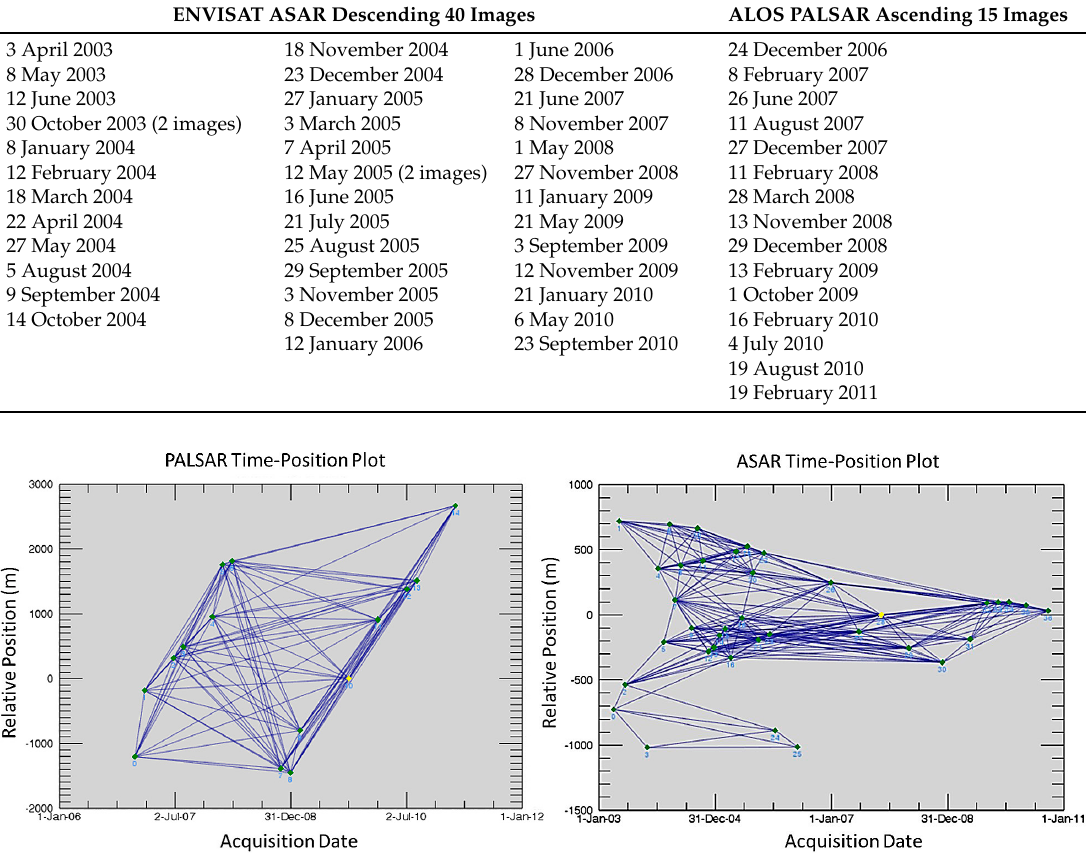
Figure 3. Normal baselines (y-axis) and the acquisition dates (x-axis). The yellow diamonds refer to the Small Baseline Subset (SBAS) super master image (1 October 2009, for Phased Array L-band Synthetic